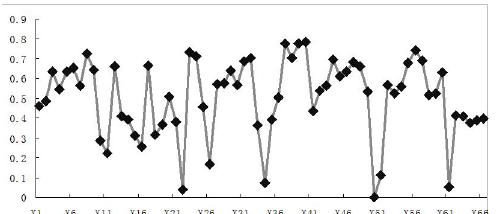
Figure 3. Goodness of fitting between rice chlorophyll and vegetation